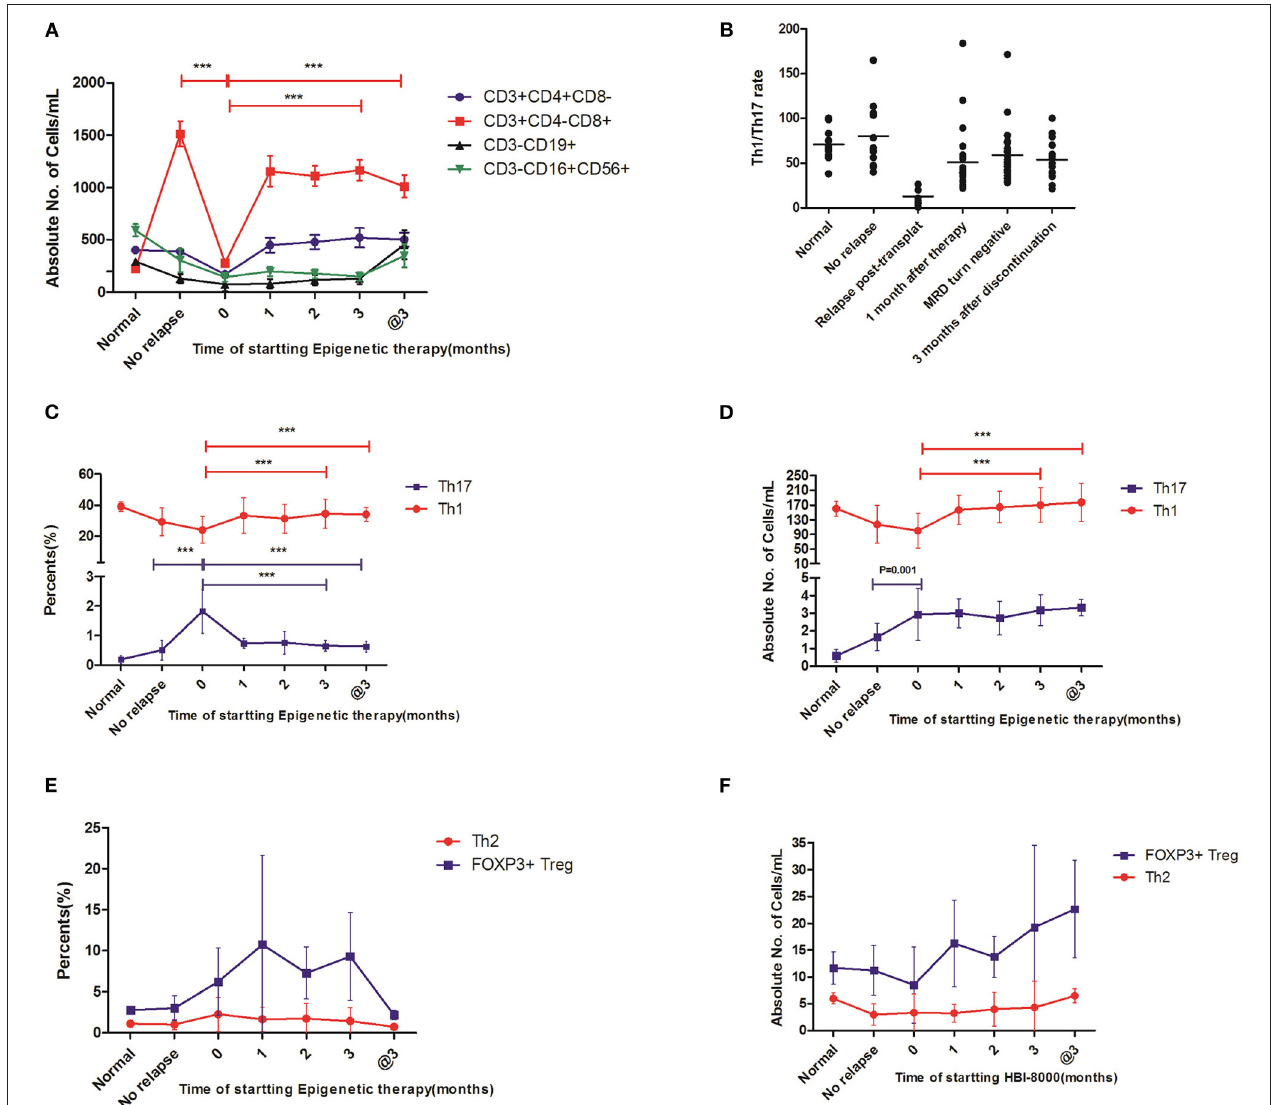
FIGURE 2 | The immunological effect of this epigenetic regimen on these relapse patients post-transplantation. Statistical differences are marked by the P -values. @3, on the 3rd month after discontinuation of this regimen. (A) The changes of absolute counts in CTL, T helper, NK, and Treg cells showed significantly decreased absolute counts of CTL cells and T helper cells in the patients with relapse and also showed that CTL cells increased gradually after this epigenetic regimen, whereas no statistical differences were observed in T helper, NK, and Treg cells. (B) The Th1/Th17 ratio significantly decreased in patients with relapse and increased gradually after this epigenetic regimen. (C,D) The changes in Th1 and Th17 cells showed that both percentages and absolute counts of Th1 cells increased gradually after this epigenetic regimen. In contrast, Th17 cells decreased gradually in percentages, whereas there was no statistical difference in absolute counts. (E,F) The changes in Th2 and Treg cells in percentage and absolute counts showed no statistical differences after this epigenetic regimen *** P <